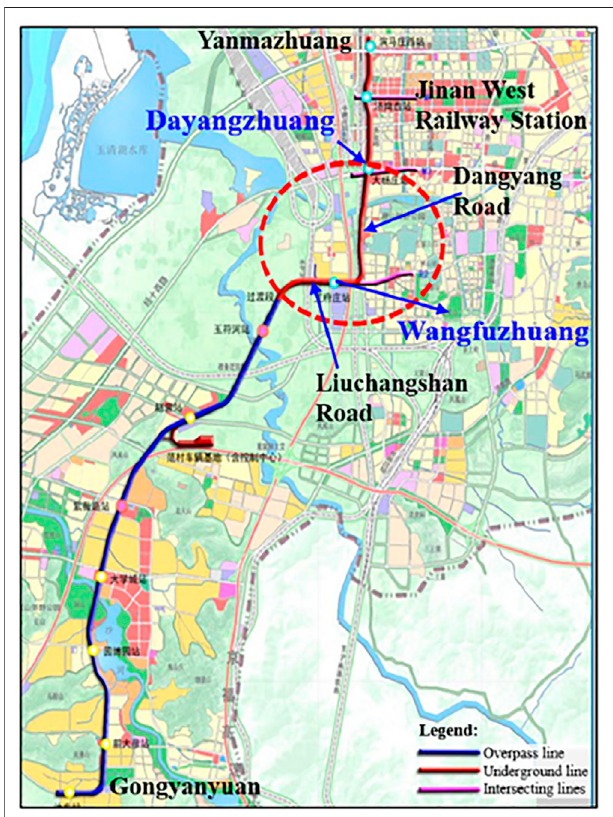
FIGURE 1 | Schematic diagram of Jinan Metro Line